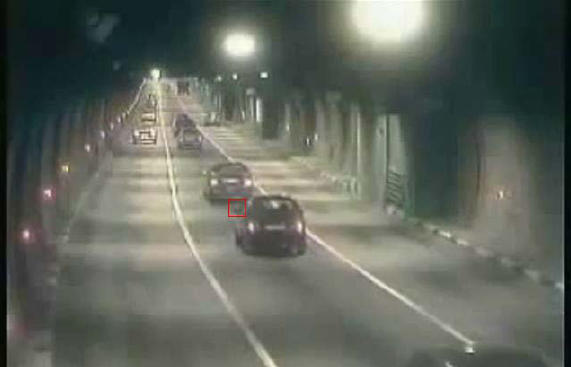
Fig. 9. Illustration of the ANN algorithm. A side mirror is recognized instead of a whole vehicle.